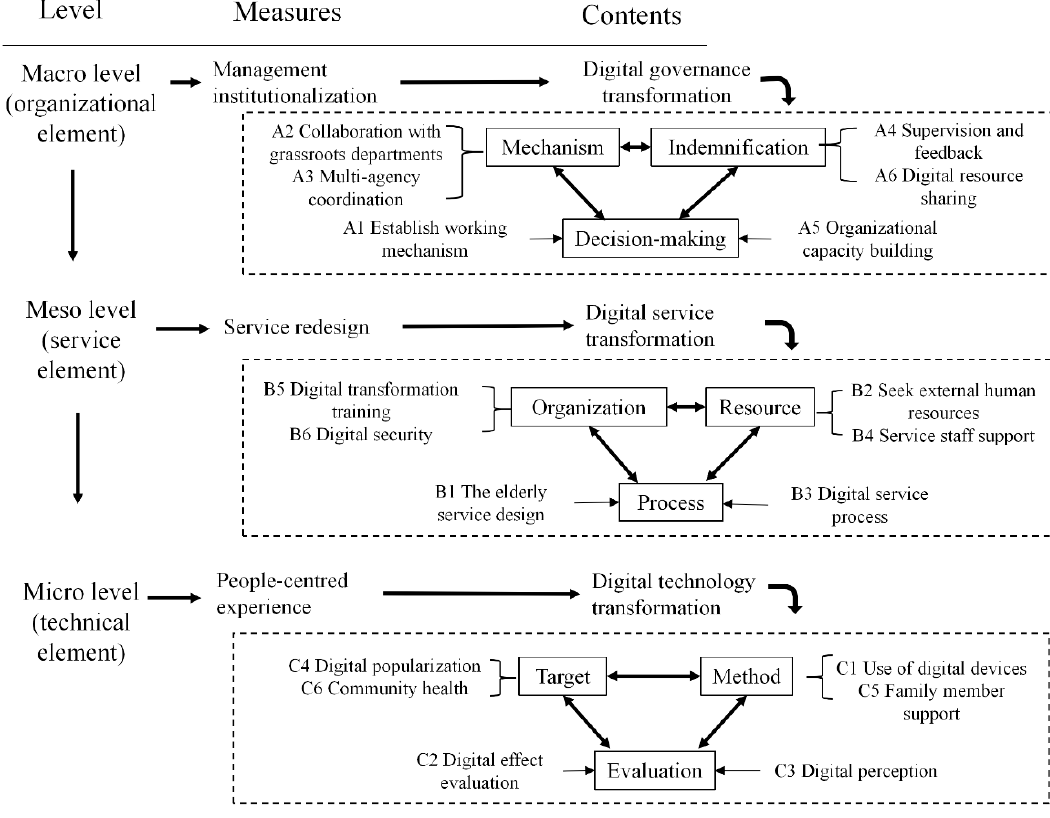
Figure 6. Age-appropriate transformation model of digital health services.